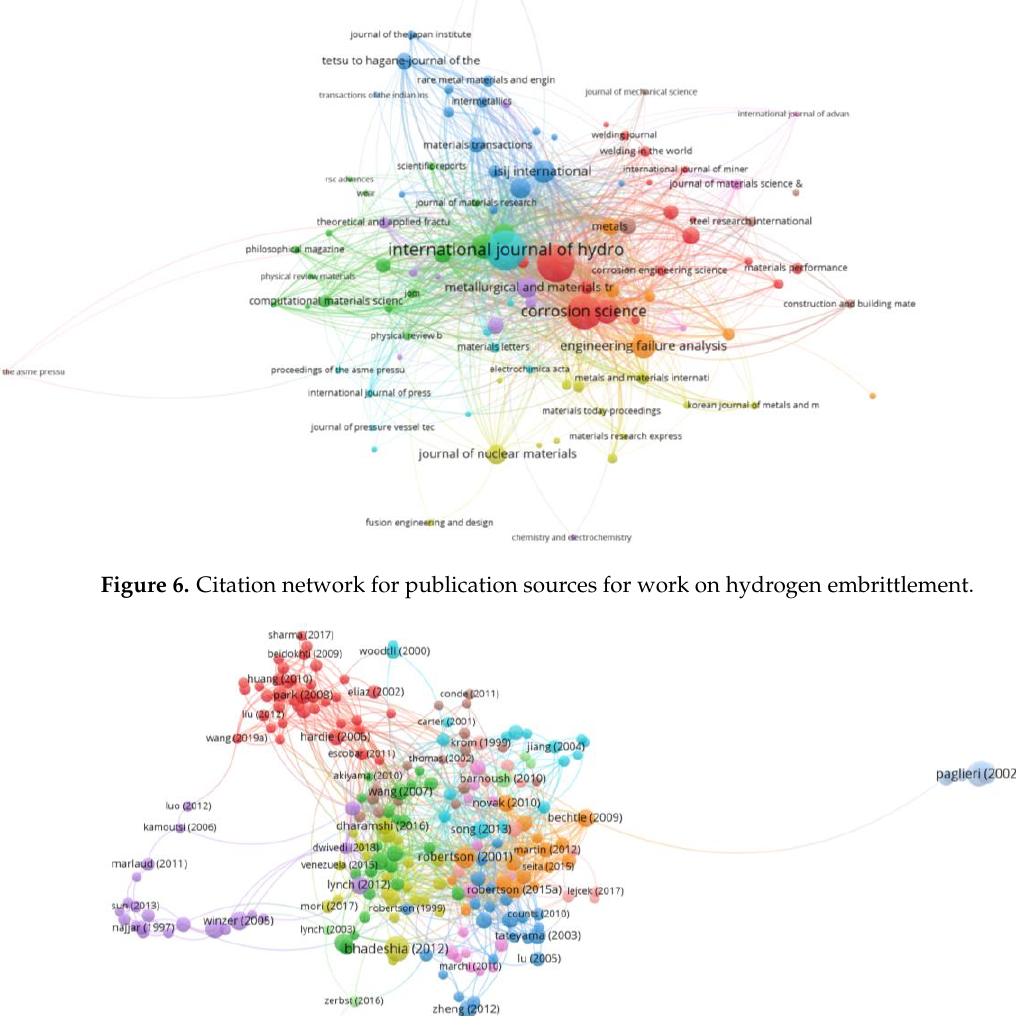
Figure 7. Citation network for highly cited references used in publications on hydrogen embrittle- ment.